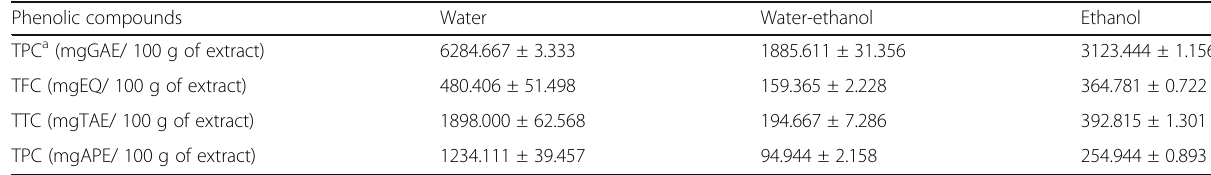
Table 2 Results of phenolic compounds